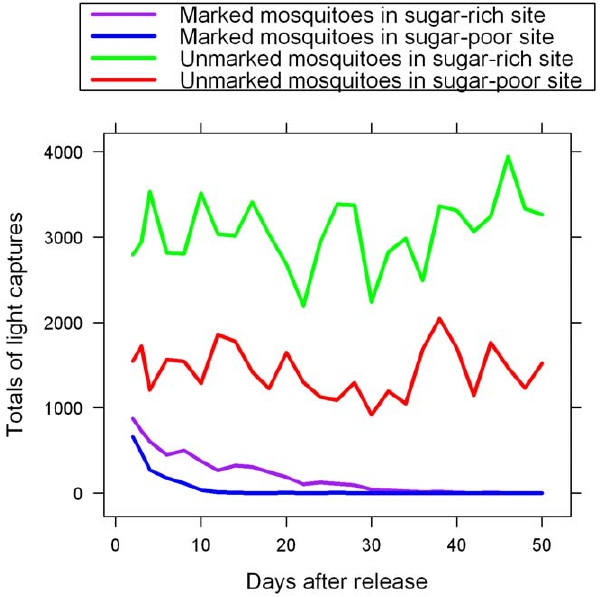
Figure 2. Age structure of unmarked local Anophelessergentii , as determined by the number of dissected ovariole dilatations at two sites with different levels of sugar supply.